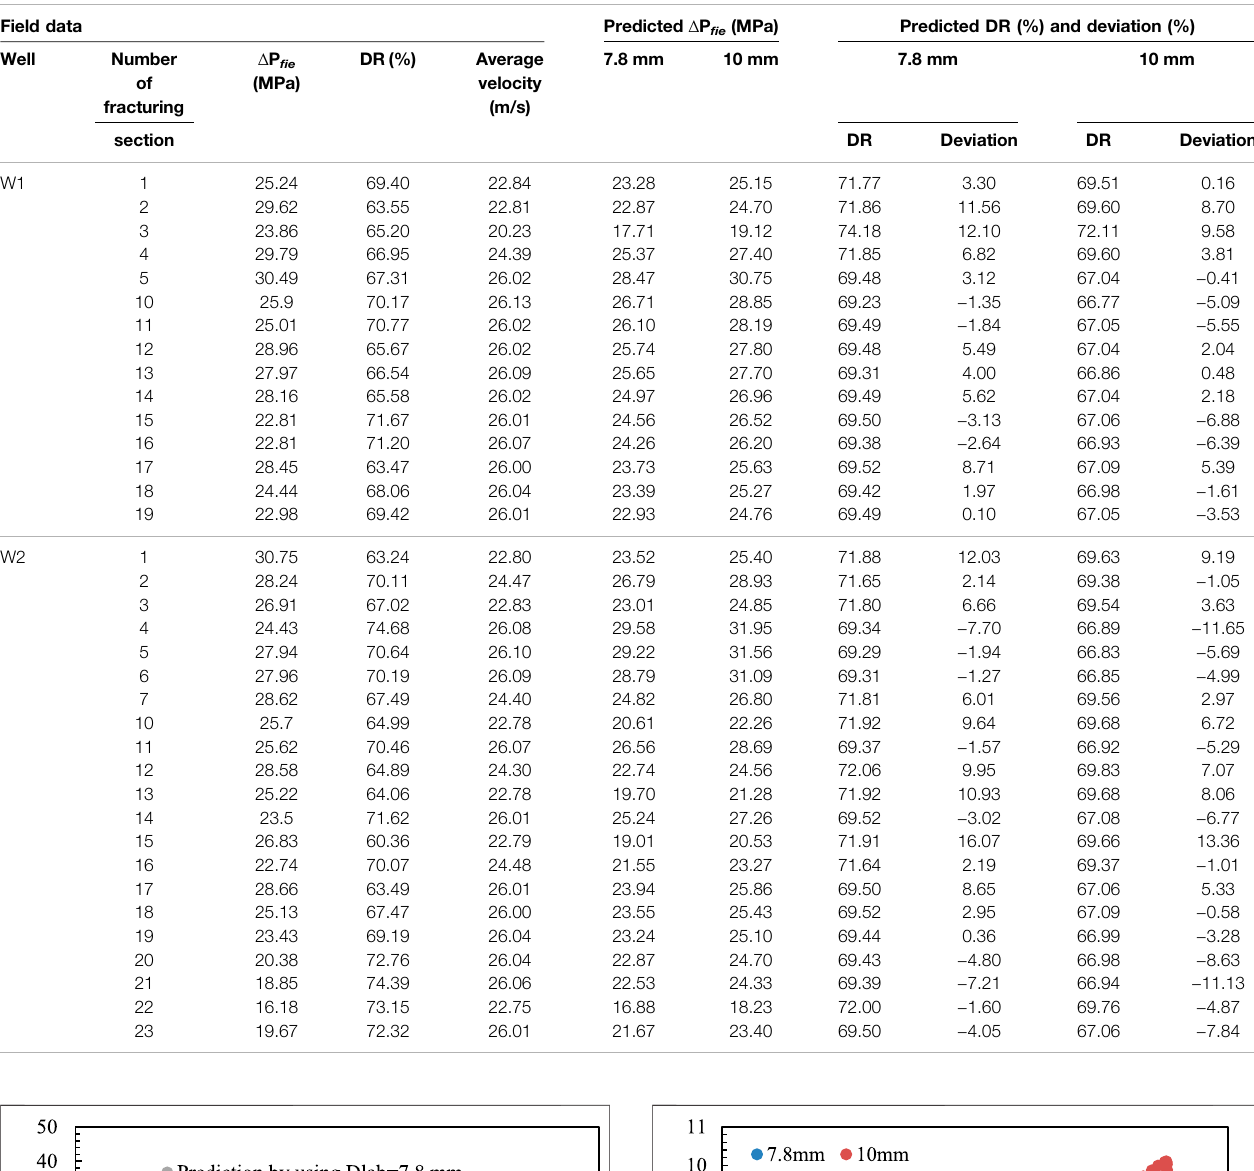
TABLE 1 | Predicted DRs and deviations obtained by using general model 1. Field data